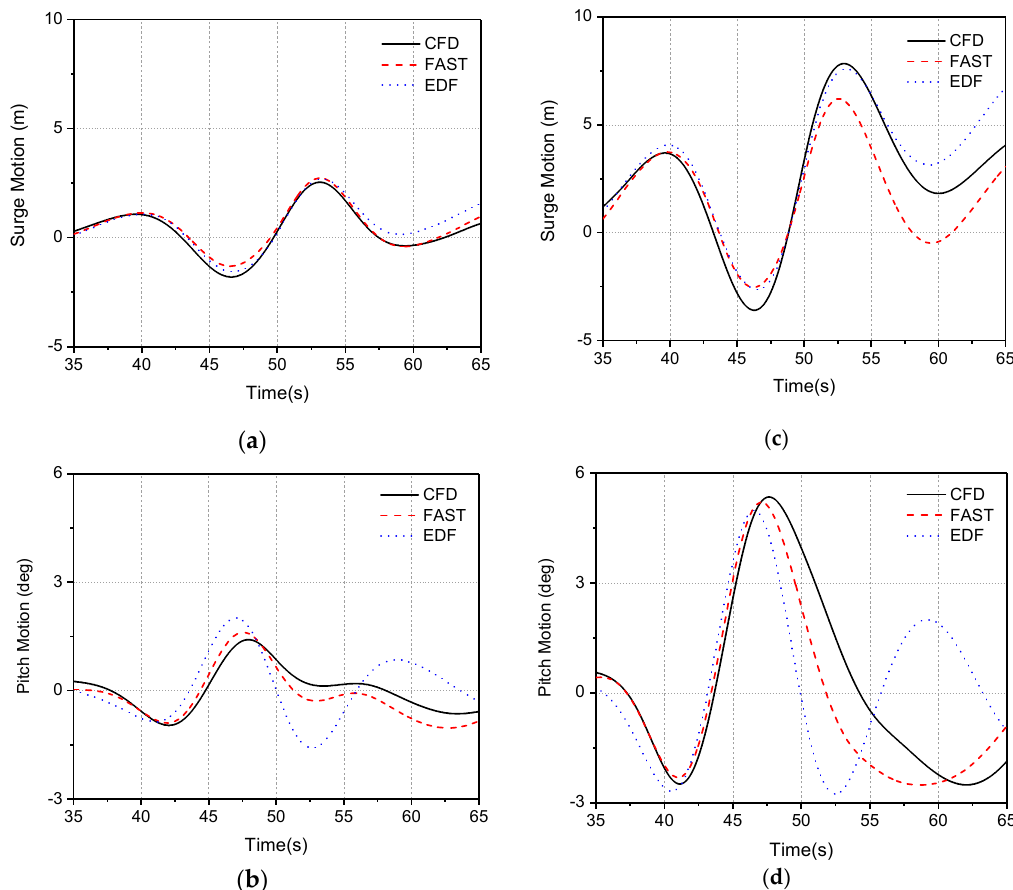
Figure 21. Surge and pitch motion comparison between CFD and potential flow theory tools: ( a ) Surge motion ( H s = 6.0 m, T p = 15.0 s) ( b ) Pitch motion ( H s = 6.0 m, T p = 15.0 s) ( c ) Surge motion ( H s = 14.7 m, T p = 15.0 s) ( d ) Pitch motion ( H s = 14.7 m, T p = 15.0 s).